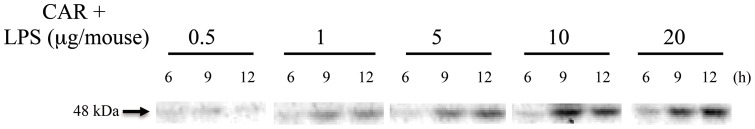
sCD14 level in the plasma of CAR-primed endotoxin shock-induced model mice at various doses of LPS.Plasma was collected from CAR-primed C57BL/6 mice that were administered with LPS at the indicated time. Soluble CD14 in the plasma was detected as follows: Each plasma sample was diluted 20 folds with saline, and then subjected to SDS-PAGE and subsequent western blotting. Then, sCD14 on the membrane was detected using anti-mouse CD14 polyclonal antibody.